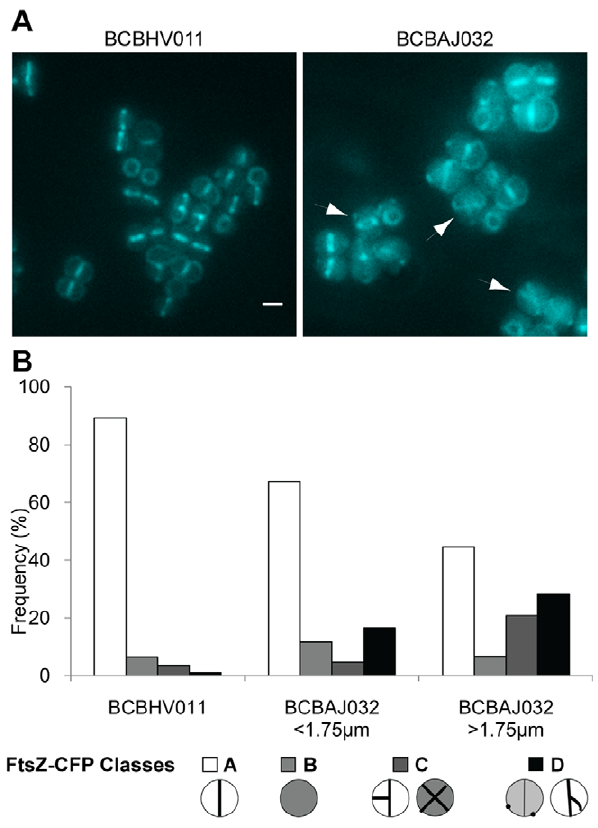
Figure 4. FtsZ mislocalizes in large S.aureus cells depleted of EzrA. (A) Fluorescence images of parental strain BCBHV011 (NCTC8325- 4 spa ::P spac ftsz-cfp ) and ezrA null mutant BCBAJ032 (NCTC8325-4 D ezrA spa ::P spac ftsz-cfp ) showing cells expressing FtsZCFP fusion protein. Arrows point to irregular localizations of FtsZ. Scale bar 1 m m. (B) Frequency of cells with septal localization of FtsZ-CFP (class A), fluorescence all over the cytoplasm (class B), double septa (class C) and irregular localizations of FtsZCFP (class D), for BCBHV011 (parental strain; NCTC8325-4 spa ::P spac ftsz-cfp ) and BCBAJ032 (NCTC8325-4 D ezrA spa ::P spac ftsz-cfp ). Cells of null mutant strain BCBAJ032 were divided in two classes - cells with a diameter smaller or larger than 1.75 m m – which were analyzed separately.